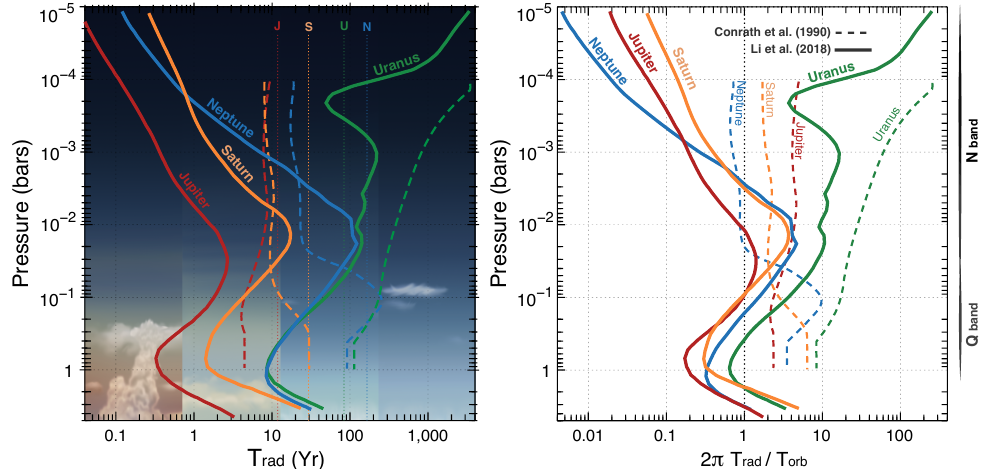
Figure 15. Theoretical radiative time constants for the giant planets. Plots show these characteristic timescales for each planet over a range of pressures, as derived in two separate studies—dashed lines are Conrath et al. [211] while solid lines are from Li et al. [326]. The left plot presents the radiative time constant in years, with the orbital periods of each planet indicated by the vertical dotted lines (labeled “J” for Jupiter, “S” for Saturn, etc.). The right plot expresses the values in terms of a ratio parameter (of a form akin to the resonance behavior of an underdamped harmonic oscillator [211]), for which values of order unity or smaller indicate the potential for stronger seasonal responses. The approximate pressures sensed by the N and Q bands are suggested at the far right. Note that Uranus has the longest radiative time constants throughout the